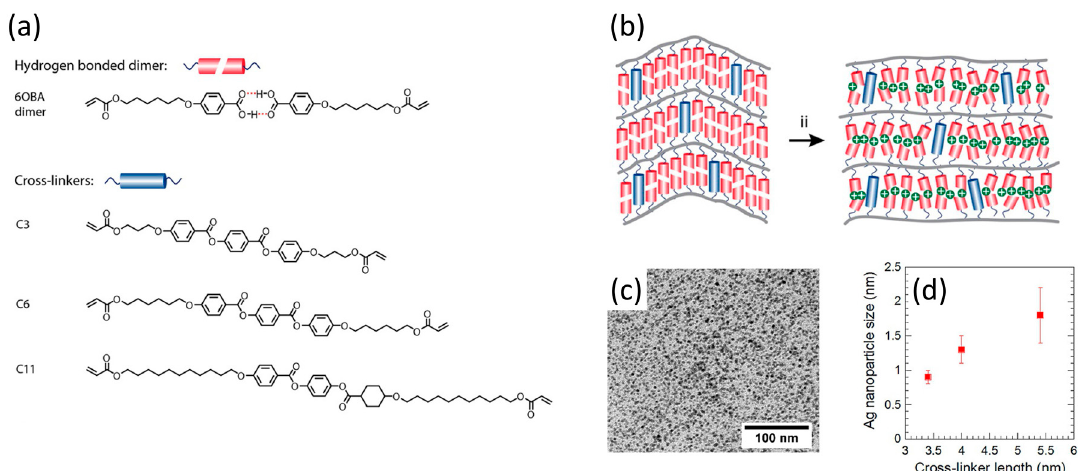
Figure 11. Synthesis of Ag nanoparticles inside 2D lamellae of a smectic LC network. ( a ) The molecular structure of the pore interior; ( b ) Schematic of converting the pore interior to the metal salt; ( c ) TEM image of particle distribution in the LC scaffold; ( d ) Mean particle size as a function of cross-linker length. Adapted from [80], under the terms of a Creative Commons Attribution-NonCommercial 4.0 International (CC BY-NC 4.0) License.